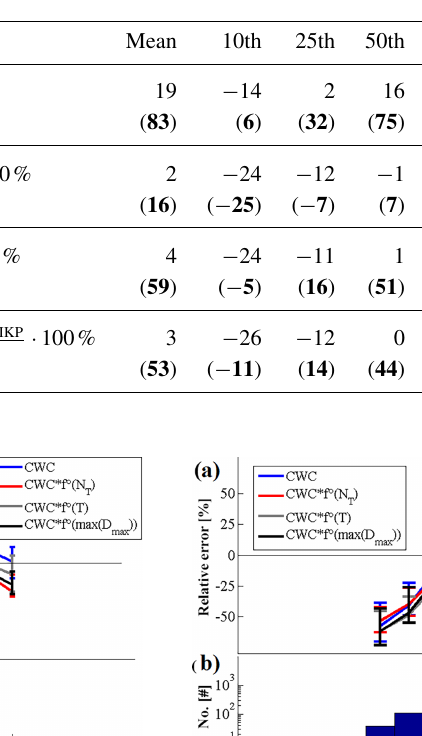
Table 1. Mean relative errors, 10th, 25th, 50th, 75th, and 90th percentiles (in %) of retrieved CWCs with respect to CWC IKP . Black numbers are for the entire dataset and bold numbers are respective relative errors for graupel events only.